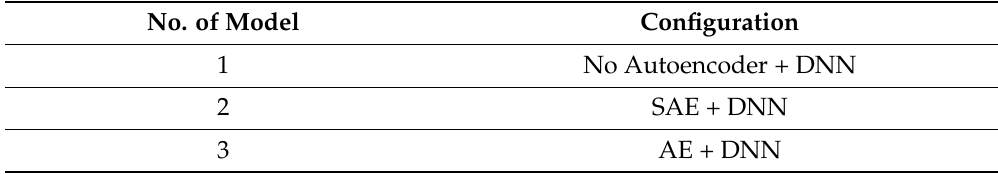
Table 9. Ensemble of Autoencoders and DNN